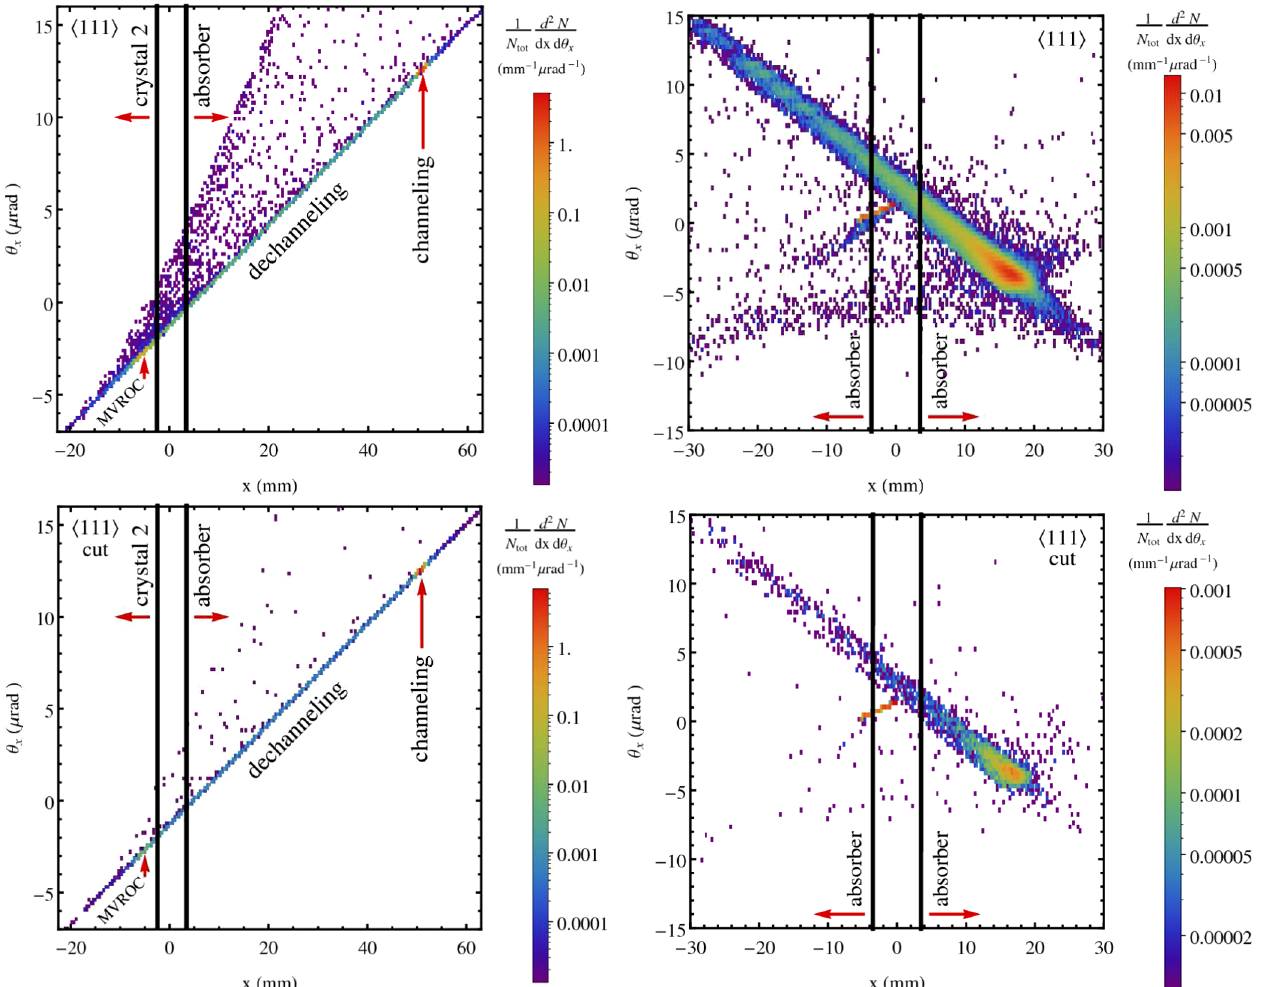
FIG. 14. Beam phase space, normalized to the total number of particles, passed through the cleaning insertion, at the position of the first (left) and the second (right) absorber for double crystal-based collimation system. The first Si crystal the same as in Fig. 10, aligned for planar channeling in skew (110) crystal planes, formed by h 111 i axes, without the cut (top) and with the cut (bottom). The second Si crystal is the same as in Fig. 8, aligned for MVROC. The first and second crystal are placed at 7.2 and 9 σ , respectively, as well as the absorbers are placed at 12 . 6 σ